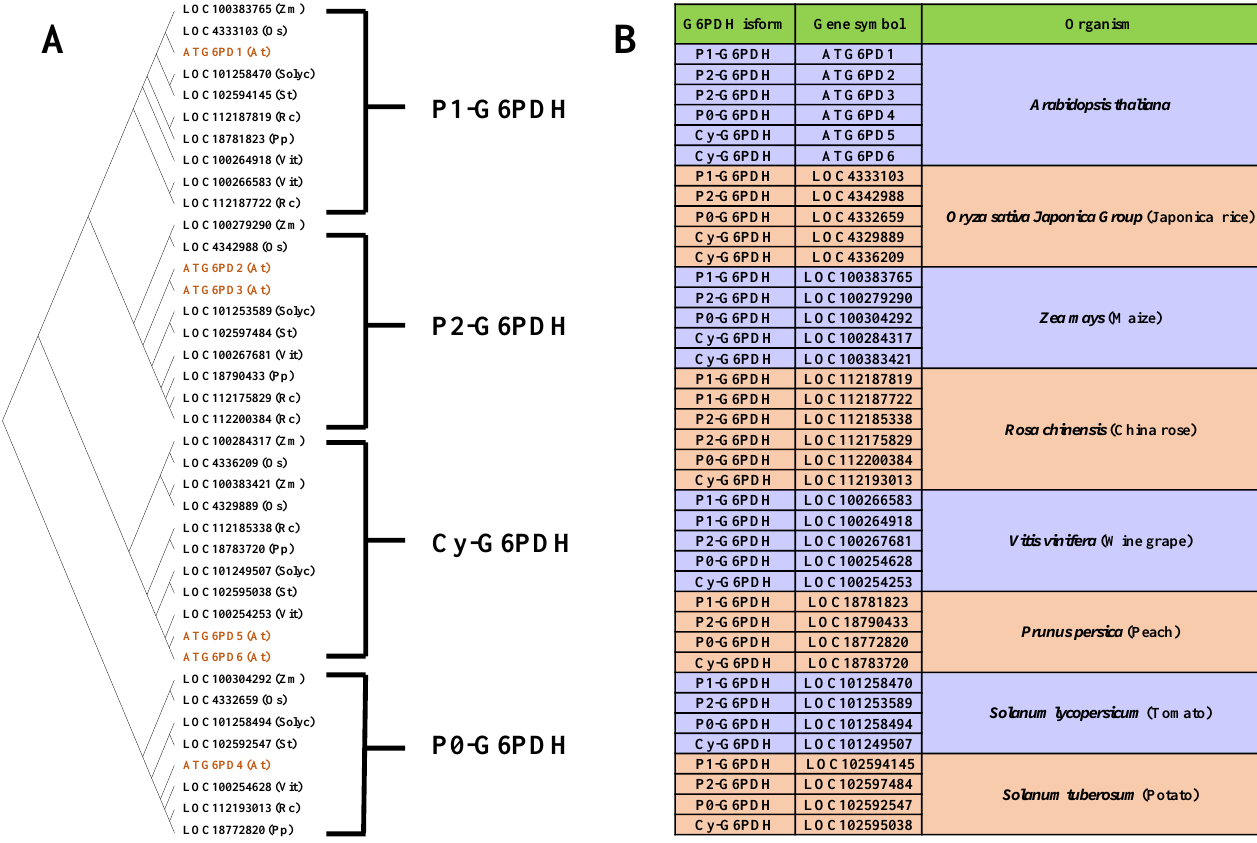
Figure 2. Comparison of different G6PDH isoforms from 8 higher plants; ( A ), phylogenetic tree showing the relative positions of 39 different gene encoding isoforms from higher plants, inferring by the maximum likelihood method of complete protein sequences; 10 sequences are P1-G6PDH, 10 sequences are P2-G6PDH, 8 sequences are P0-G6PDH; and 11 sequences are Cy-G6PDH. Legend for plant species: At, Arabidopsis thaliana ; Os, Oryza sativa Japonica Group ; Zm, Zea mays ; Rc, Rosa chinensis ; Vit, Vitis vinifera ; Pp, Prunus persica ; Solyc, Solanum lycopersicum ; St, Solanum tuberosum . ( B ), List of G6PDH isoforms and their relative gene symbol from different higher plants, summarizing from the phylogenetic tree constructed in ( A ). The complete list of sequences using for tree construction is showed in Table